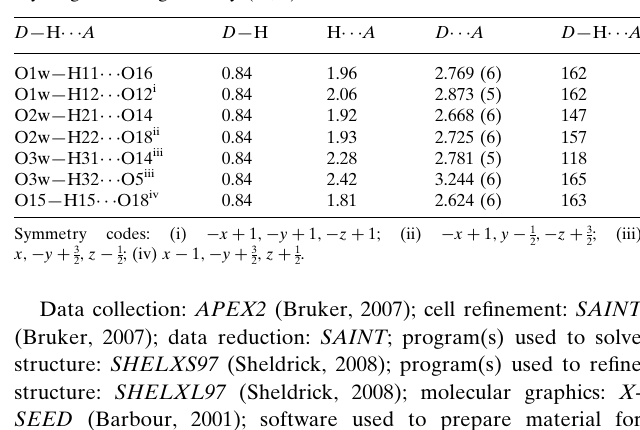
Hydrogen-bond geometry (A˚ , (cid:2)